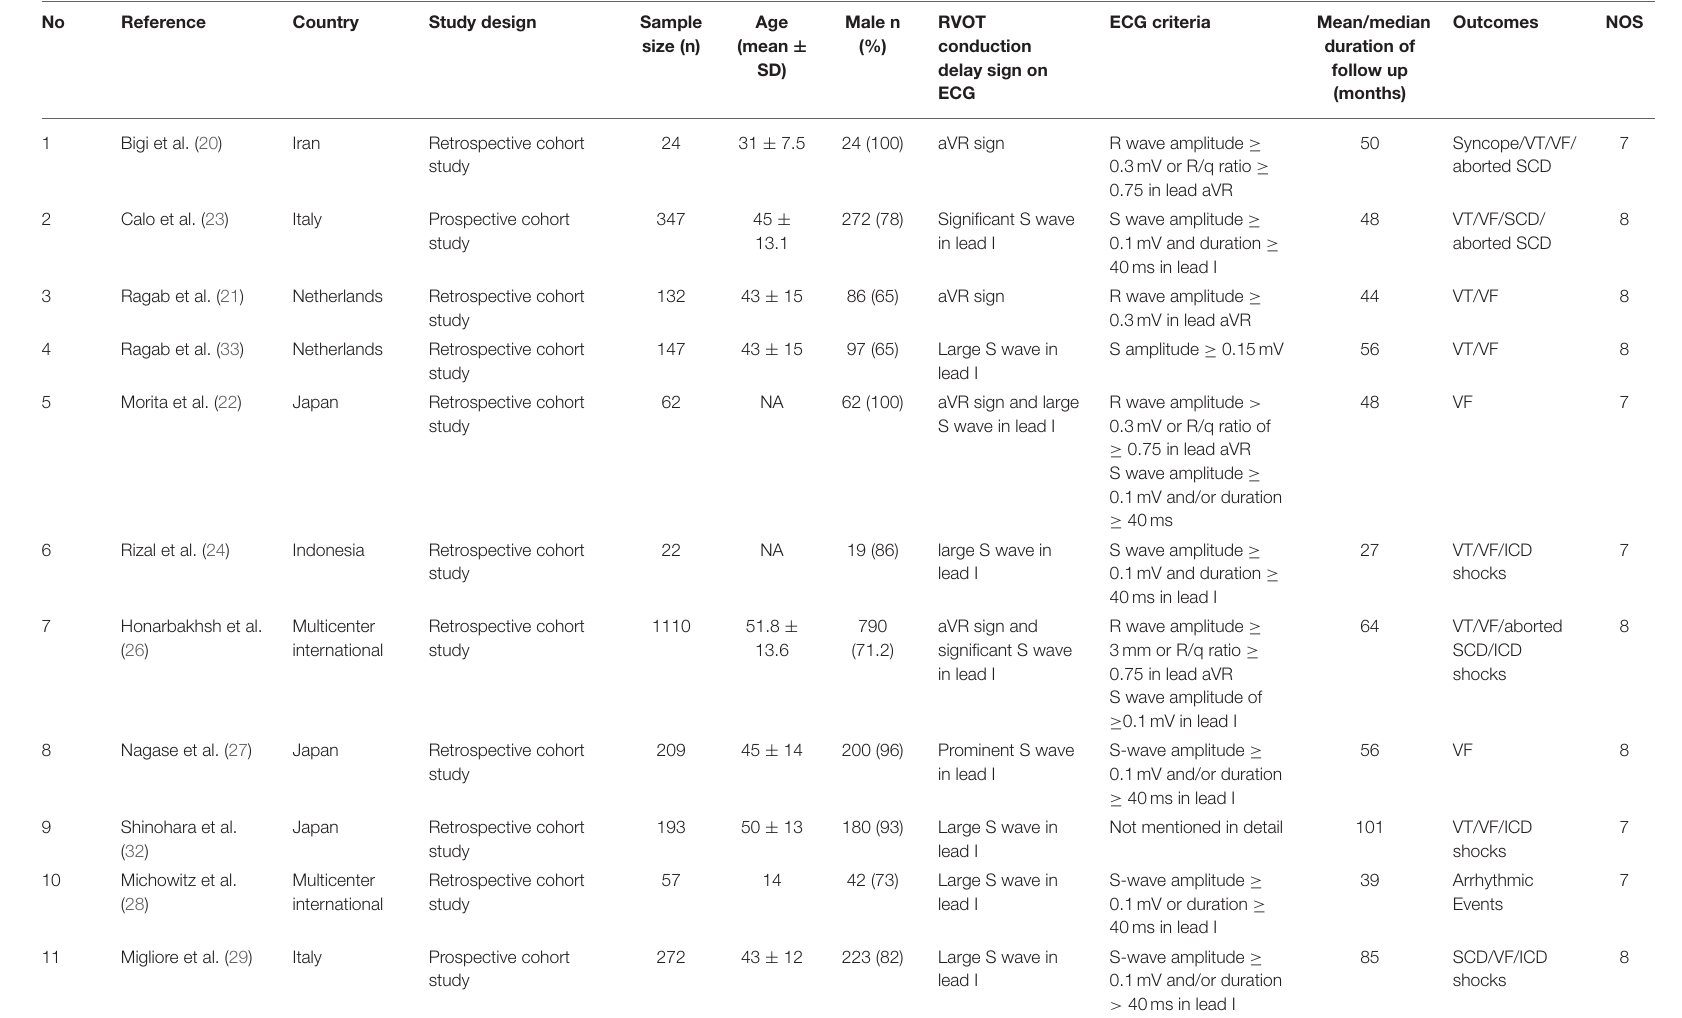
TABLE 1 | The characteristic of included studies.